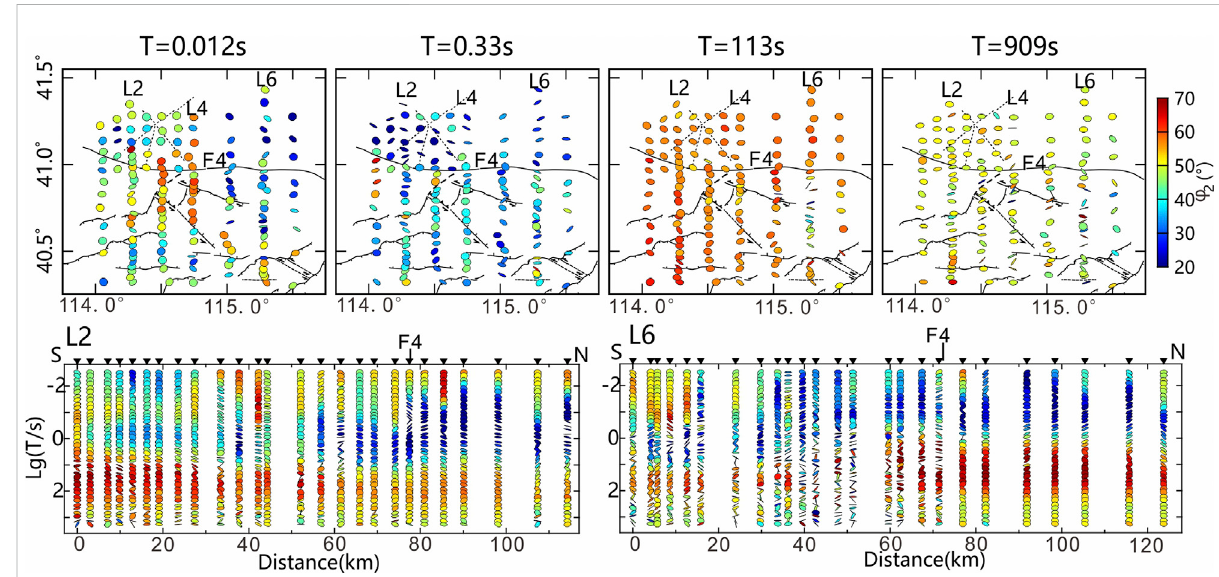
FIGURE 5 Mapview of phase tensor ellipses fi lled with the phase tensor invariant for periods 0.012 s, 0.33 s, 113 s, and 909 s (upper). Pro fi ole of phase tensor ellipses fi lled with the phase tensor invariant for pro fi les L2 and L6 (bottom).